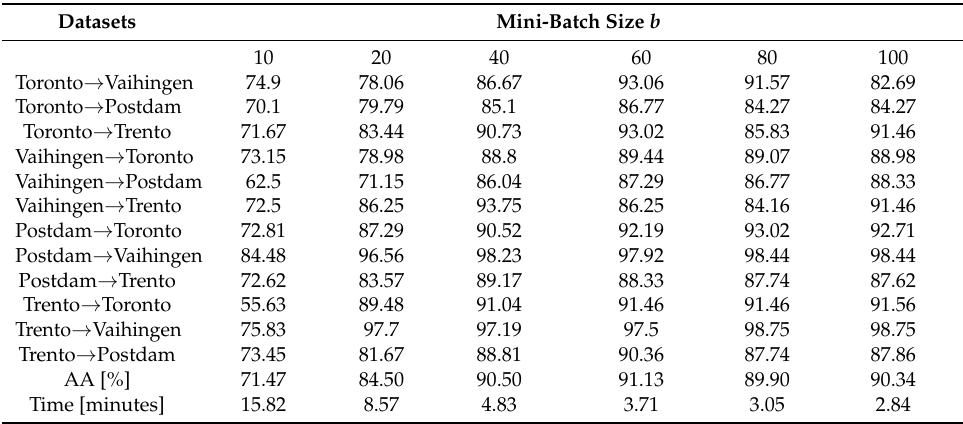
Table 4. Sensitivity analysis with respect to the min-batch size b . Results are expressed in terms of OA [%] and AA [%] over the 12 scenarios.